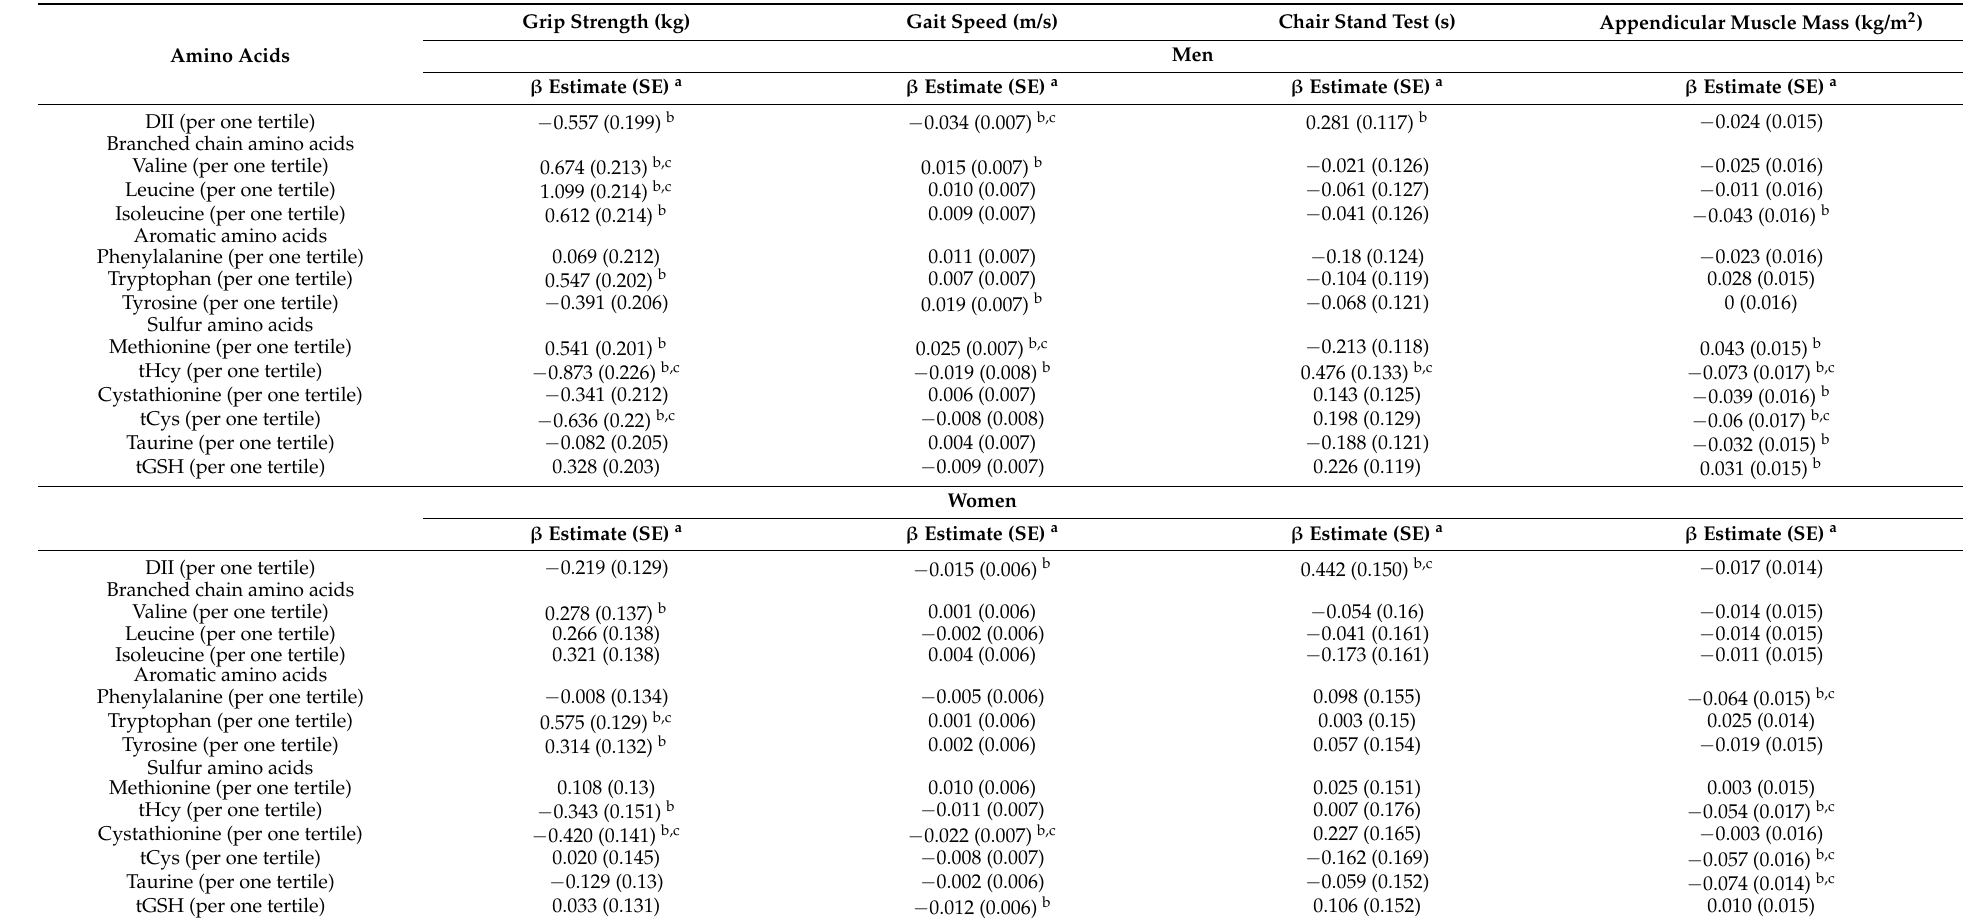
Table 2. The association of DII and serum amino acids with the muscular parameters at